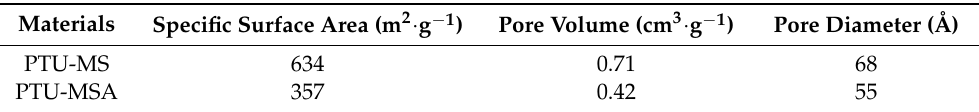
Figure 5. ( a ) SEM photograph after sulfonation of PTU-MS; ( b ) SEM photograph after sulfonation of PTU-MSA; ( c ) FT-IR spectra of PTU-MS and PTU-MSA materials; ( d ) N 2 adsorption-desorption isotherm curves of PTU-MS and PTU-MSA. Table 3. Physico-chemical properties of PTU-MS material sorption, for the examination of N 2 prior and after incorporation of a sulphonic